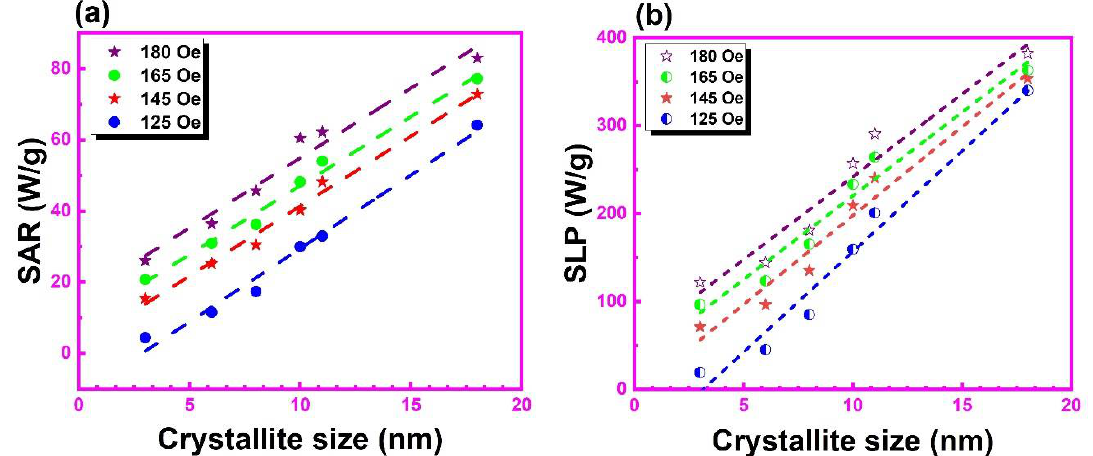
Figure 12. ( a ) SAR and ( b ) SLP of Co 15 Ni 85 NPs milled at 1425 rpm for 100, 200, 300, 500, 1000 and 1200 min as a function of average crystallite size. The straight lines guide the eye.